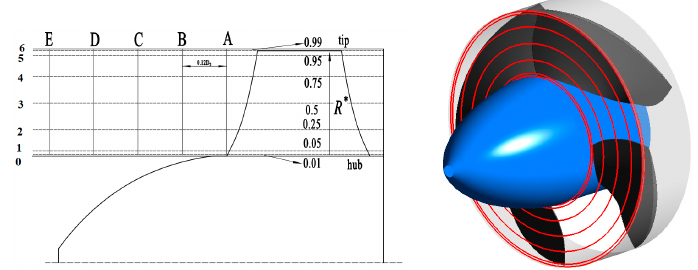
Figure 10. Schematic diagram of data sampling location.